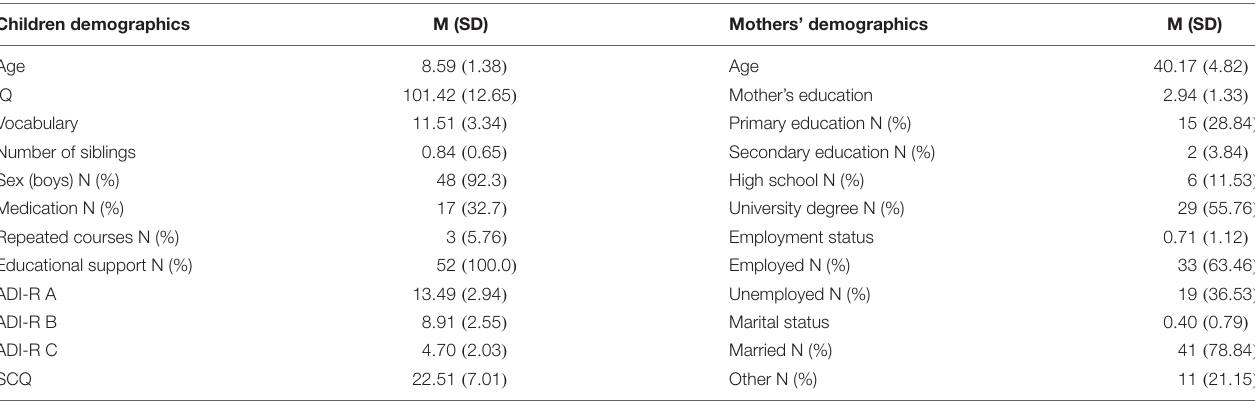
TABLE 1 | Sociodemographic characteristics of the sample ( N =